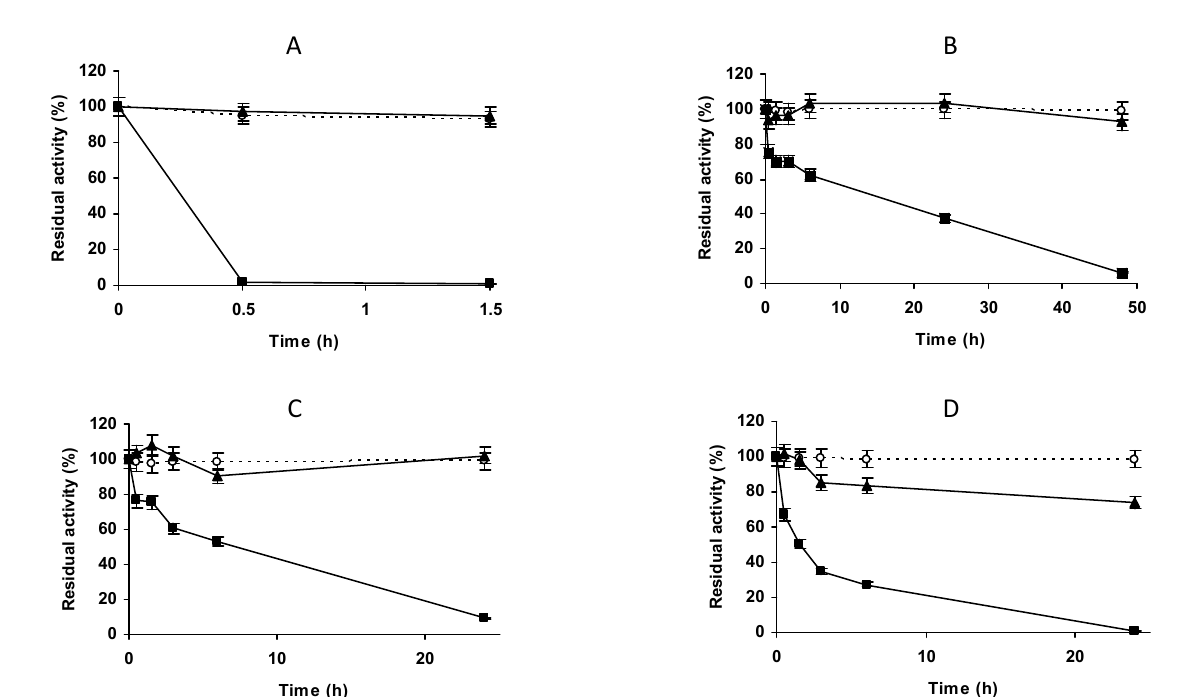
Figure 2. Immobilization courses of PGA (2.5 mg/g) on vinyl sulfone agarose at different pH values in the proportion of 1 g of support for 3 mL of enzyme solution. ( A ) immobilization on glyoxyl agarose support; ( B ) immobilization in VS-agarose at pH 7.0; ( C ) immobilization in VS-agarose at pH 8.0; ( D ) immobilization in VS-agarose at pH 9.0. Empty circles with dashed line: reference suspension. Full triangles with solid line: suspension. Full squares with solid line: supernatant. Other specifications are described in Methods.